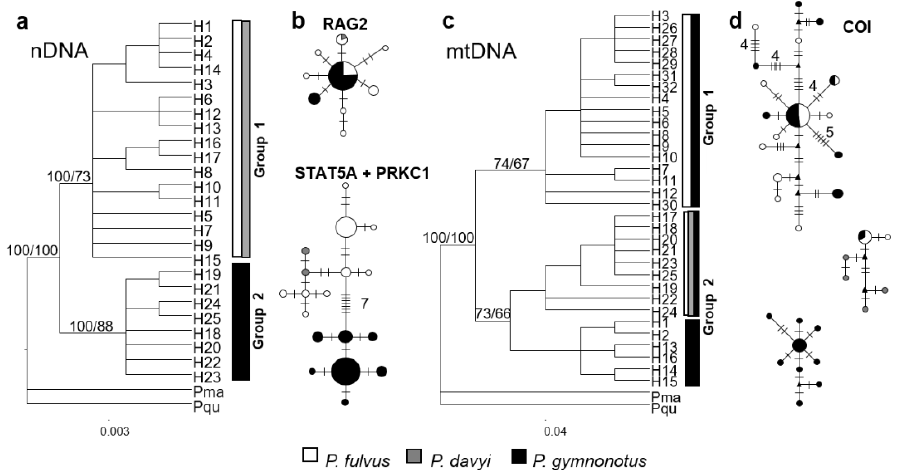
Figure 4. ( a ). Phylogenetic reconstruction based on nDNA (PRKC1+STAT5A+RAG2) with Posterior probability (IB)/Bootstrap (ML) support on the nodes and using P. macleayi (Pma) and P. quadridens ( Pqu ) as outgroups. ( b ) Haplotype Networks for nuclear markers RAG2 and STAT5A+PRKC1. Colors indicate species: white for P. fulvus , gray for P. davyi and black for P. gymnonotus . Smaller lines that connect each haplotype indicate mutational steps between them. Black-small triangle represent hypothetical haplotypes and the size of each circle represents the frequency of different haplotypes. ( c ). Phylogenetic reconstruction of mtDNA (COI). ( d ). COI haplotype network.